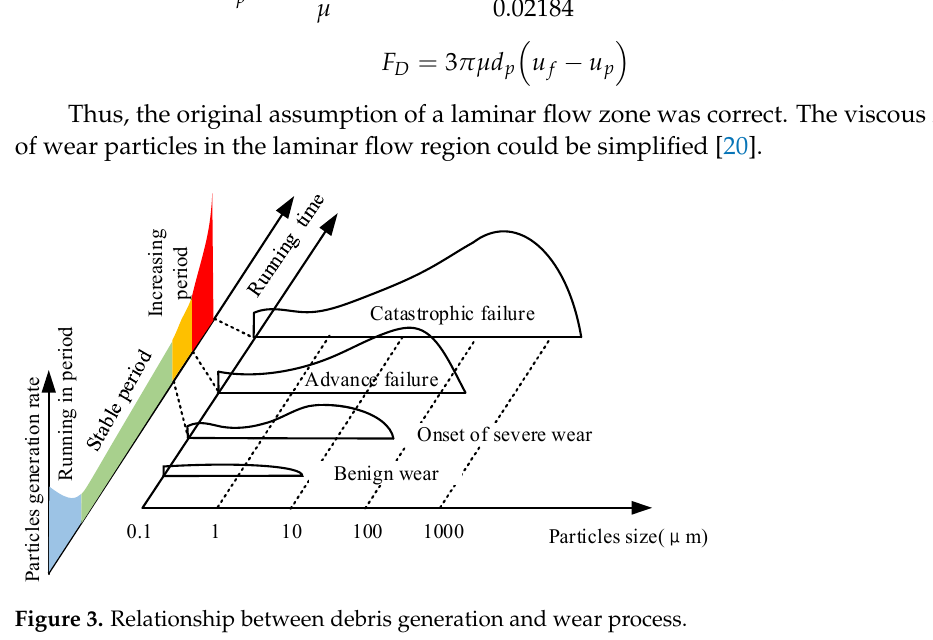
Figure 3. Relationship between debris generation and wear process. The velocity trends of different densities and diameters of wear particles in oil with time are shown in Figure 4.